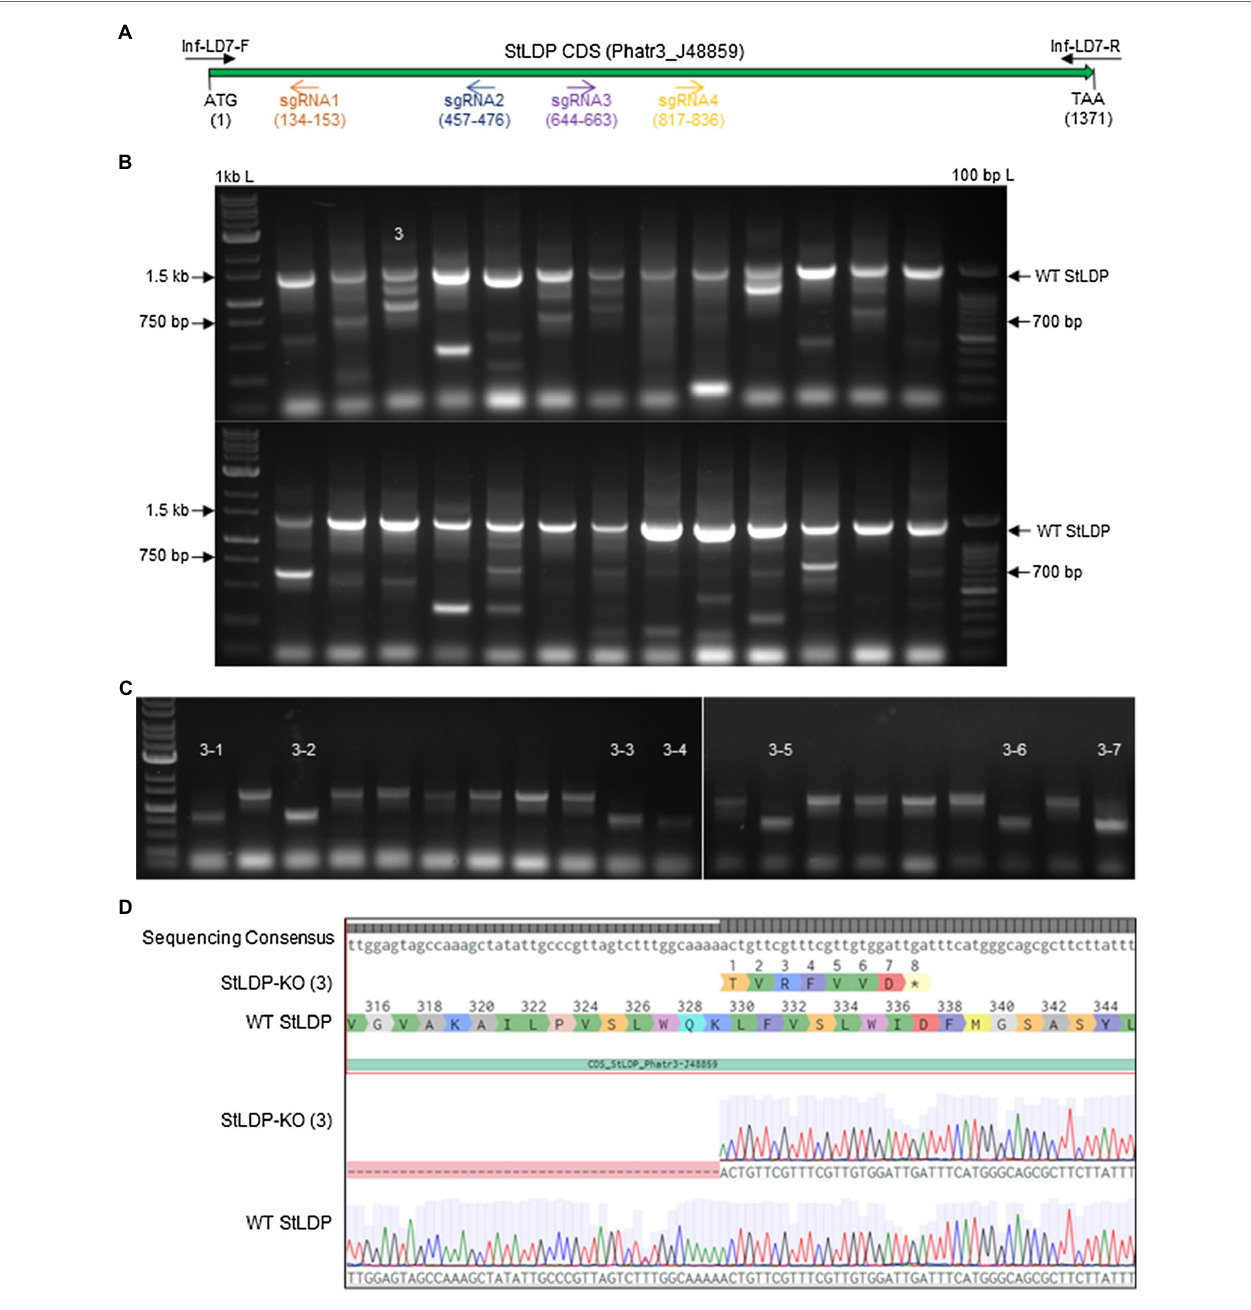
FIGURE 2 | PCR screening for gene editing in primary exconjugants in P. tricornutum Pt1 (CCAP1055/1). (A) A schematic of the StLDP gene (Phatr3_J48859), indicating positions of sgRNA-guided cleavage sites. (B) Twenty-six primary exconjugants with heterozygous or chimeric deletions in the StLDP gene are shown. Wt StLDP , amplified with INF-StLDP-F and INF-StLDP-R primers (Materials and Methods), produces a 1,400-bp product; amplicon below 700 bp indicates a deletion resulting from the multiplexed targeting of all four sgRNA. 1 kb L = GD 1 kb DNA Ladder RTU from GeneDireX Inc.; 100 bp L = 100 bp DNA Ladder RTU from GeneDireX Inc. (C) PCR screening of single colonies from primary exconjugant StLDP (3) to identify lines with homozygous deletion. (D) Partial sanger sequencing of the StLDP gene in primary exconjugant StLDP (3).